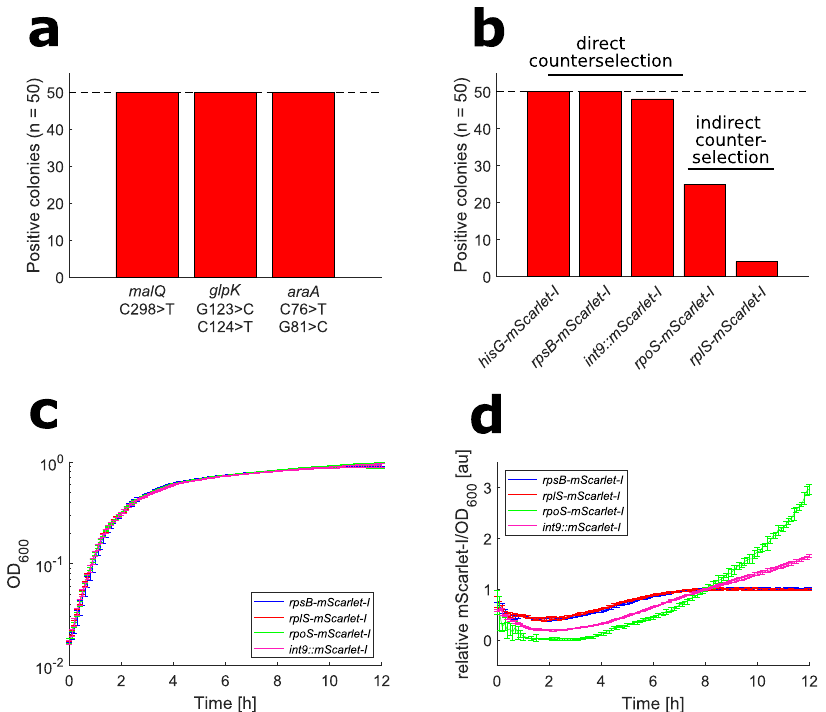
Fig. 4 Results of point mutations and integrations introduced by NT-CRISPR. a Ef fi ciency of introducing point mutations. Targeted genes are malQ (PN96_15600, Chr1), glpK (PN96_01955, Chr1) and araA (PN96_16040, Chr2). Positive colonies refer to the ability to grow on the respective carbon source ( n = 50 colonies). G > C mutation introduces a stop codon and C > T mutation (for glpK and araA ) introduces a silent mutation as a C – C mismatch to evade mismatch repair. b Integration of mScarlet-I. mScarlet-I fused to 3 ′ end of hisG (PN96_07800), rpsB (PN96_02260), rpoS (PN96_01115) and rplS (PN96_01280) and the integration of mScarlet-I with a constitutive promoter into one intergenic region between genes with locus tags PN96_06135 and PN96_06140, all on chromosome 1. Positive colonies were identi fi ed by PCR assays ( n = 50 colonies). “ Direct counterselection ” describes counterselection through a gRNA overlapping the integration site, while “ indirect counterselection ” refers to the selection through a silent point mutation ~300 bp upstream of the integration site. c Growth curves of translational fusions and strain with integrated constitutive mScarlet-I cassette. n = 8 replicates, representing four independent biological replicates and two independent experiments. Curves show the mean of all replicates and error bars indicate standard deviation of the mean. d Normalized mScarlet-I signal. mScarlet-I/OD 600 was normalized by value at timepoint 8 h to compensate for different mScarlet-I signals. Underlying data without normalization is shown in Supplementary Fig. S9. n = 8 replicates, representing four independent biological replicates and two independent experiments. Curves show the mean of all replicates and error bars indicate standard deviation of the